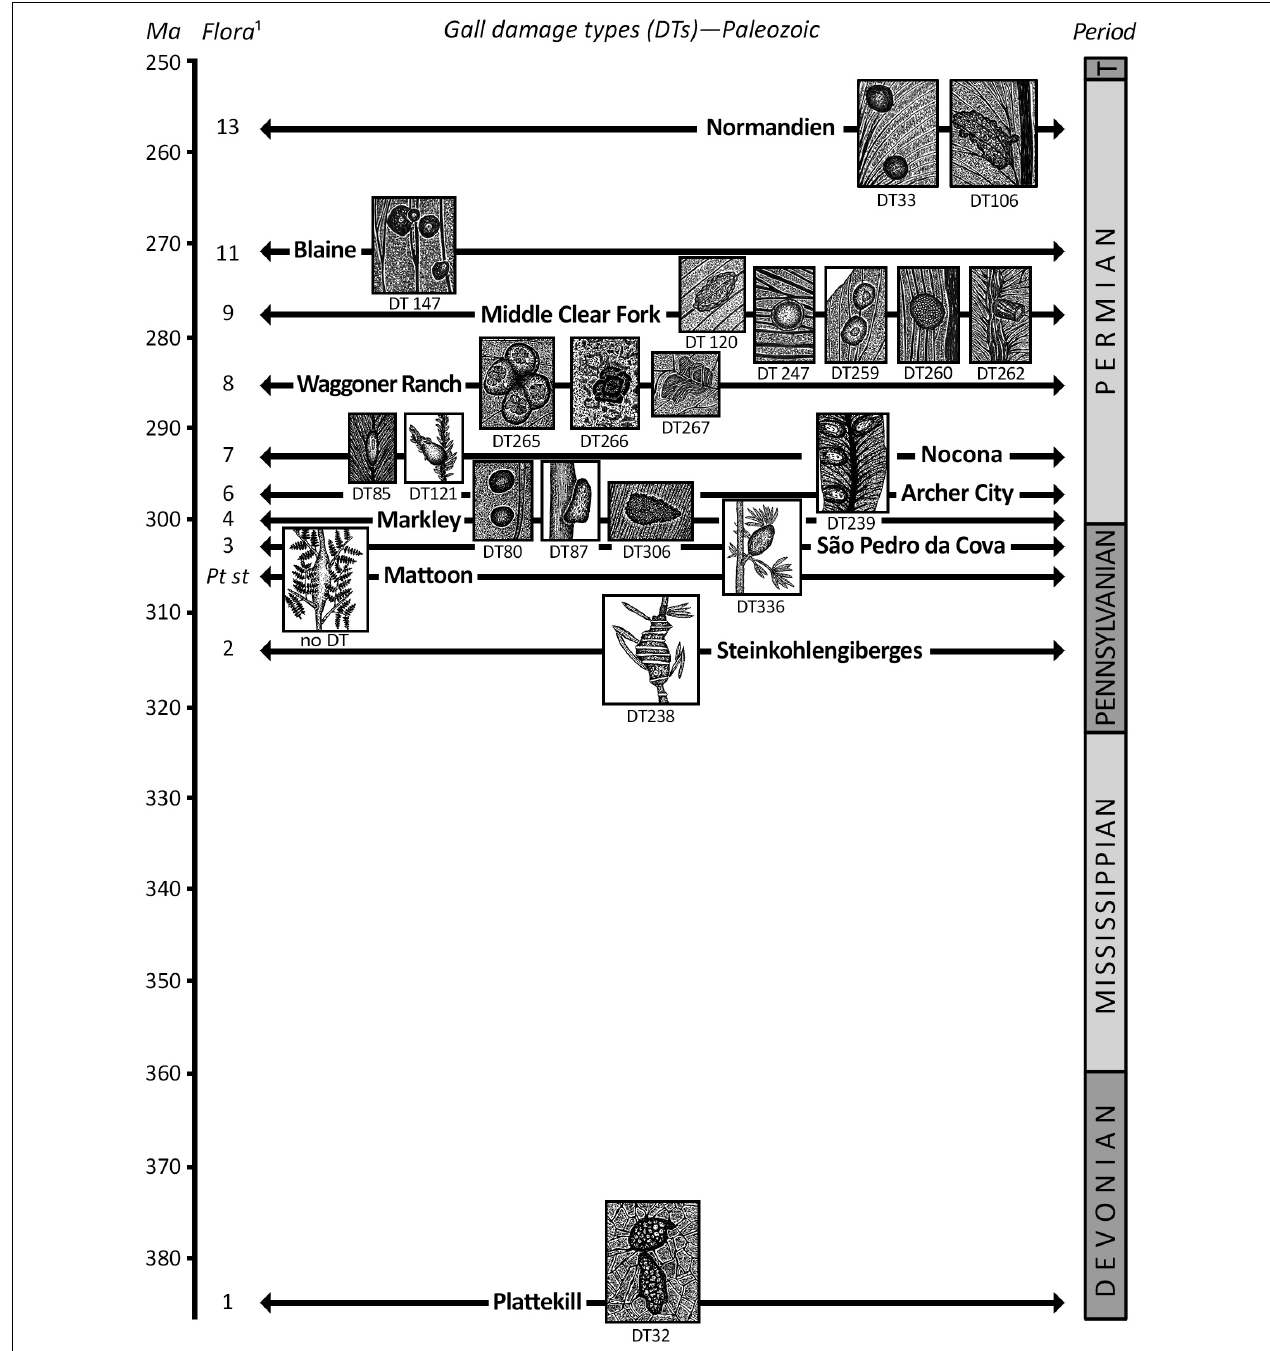
FIGURE 1 | Prominent gall damage types (DTs) for Mesozoic floras. See Supplementary Appendix for documentation. Time scale after Walker et al.